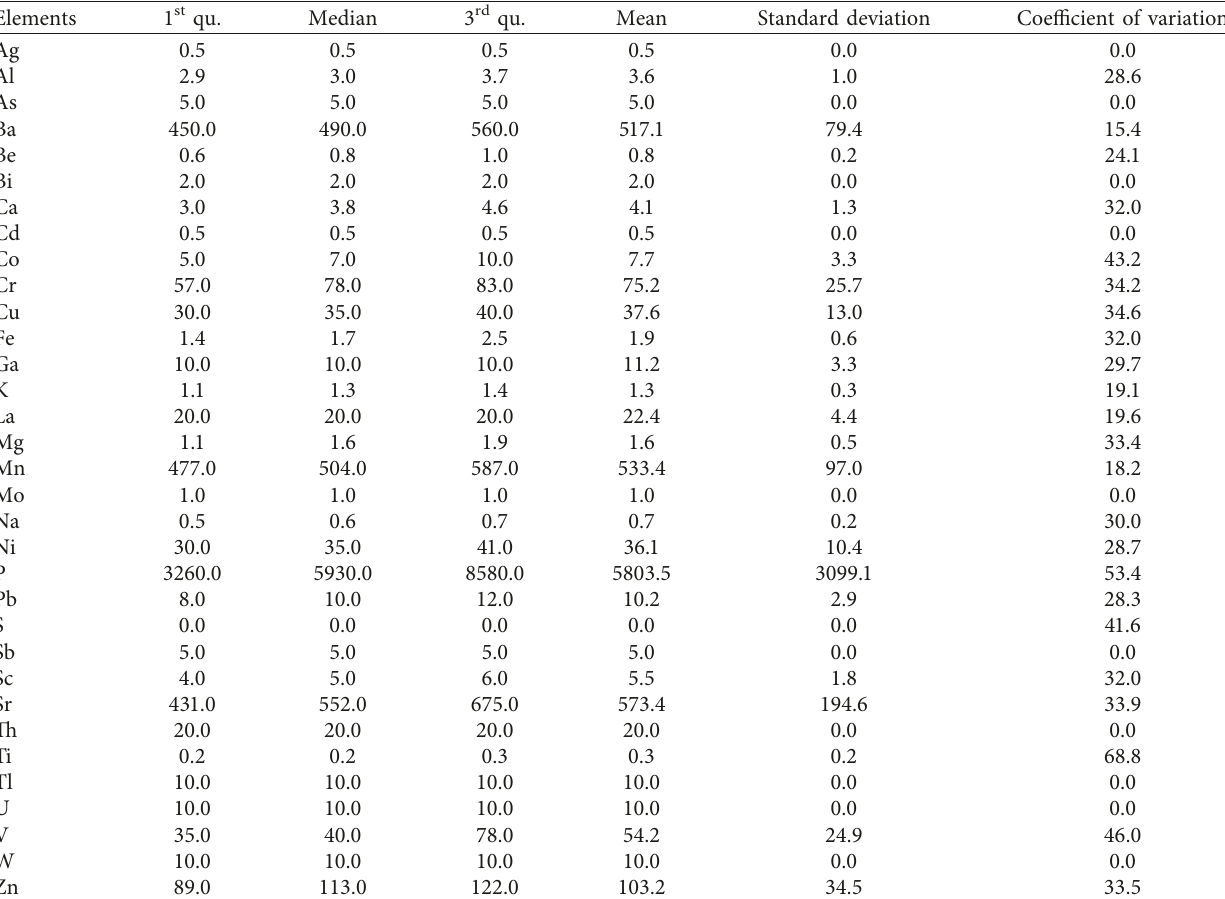
Table 3: Summary statistics for the concentration of different chemical elements within nonvitrified dung. Elements 1 st